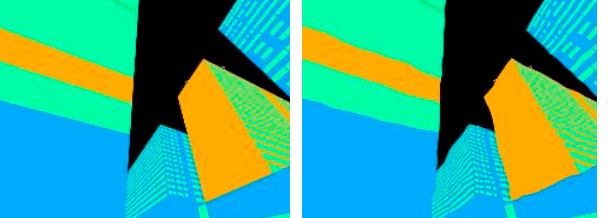
Figure 2. Example of a candidate image on the left, and a slightly elastically distorted candidate image on the right.